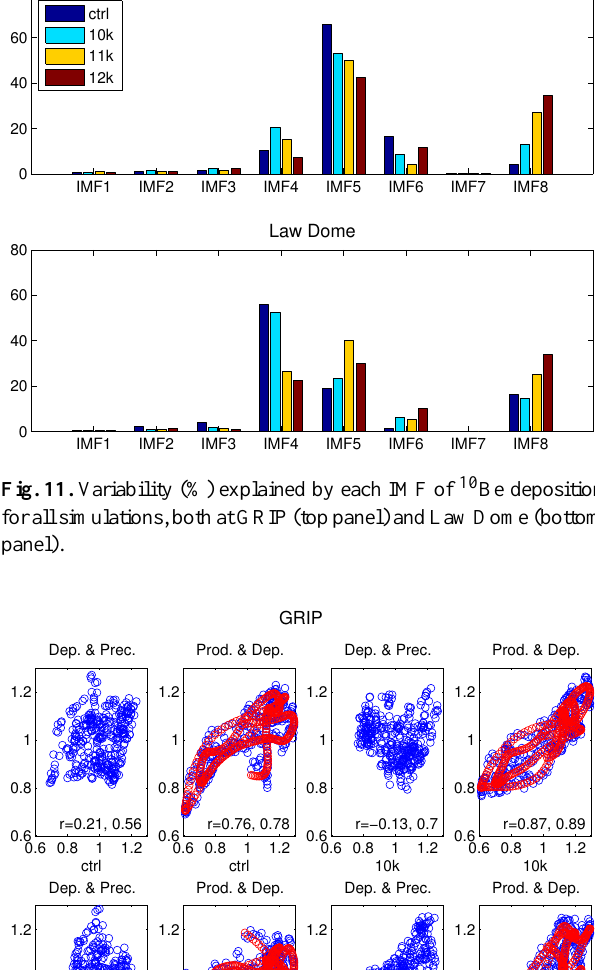
12k Fig. 13. Same as Figure 12 but for the Law Dome station.